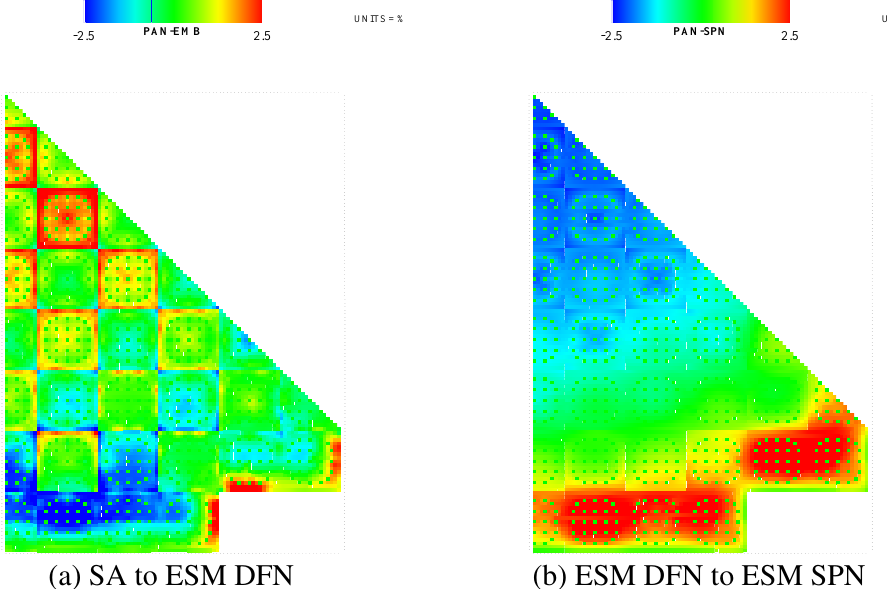
Figure 5: Pin power changes introduced by the ESM using diffusion relative to a standard two-step PANTHER diffusion solution (SA), and by the ESM using SPN relative to the ESM using diffusion, for Watts Bar 1 BOC1